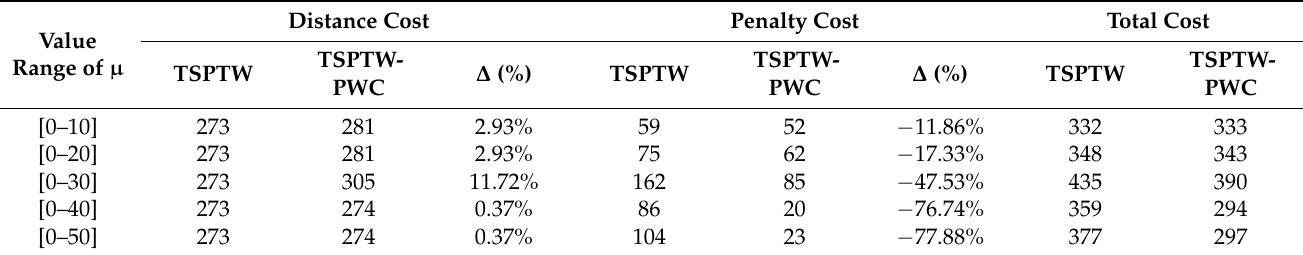
Table 3. Sensitivity analysis of waiting sensitivity parameter.